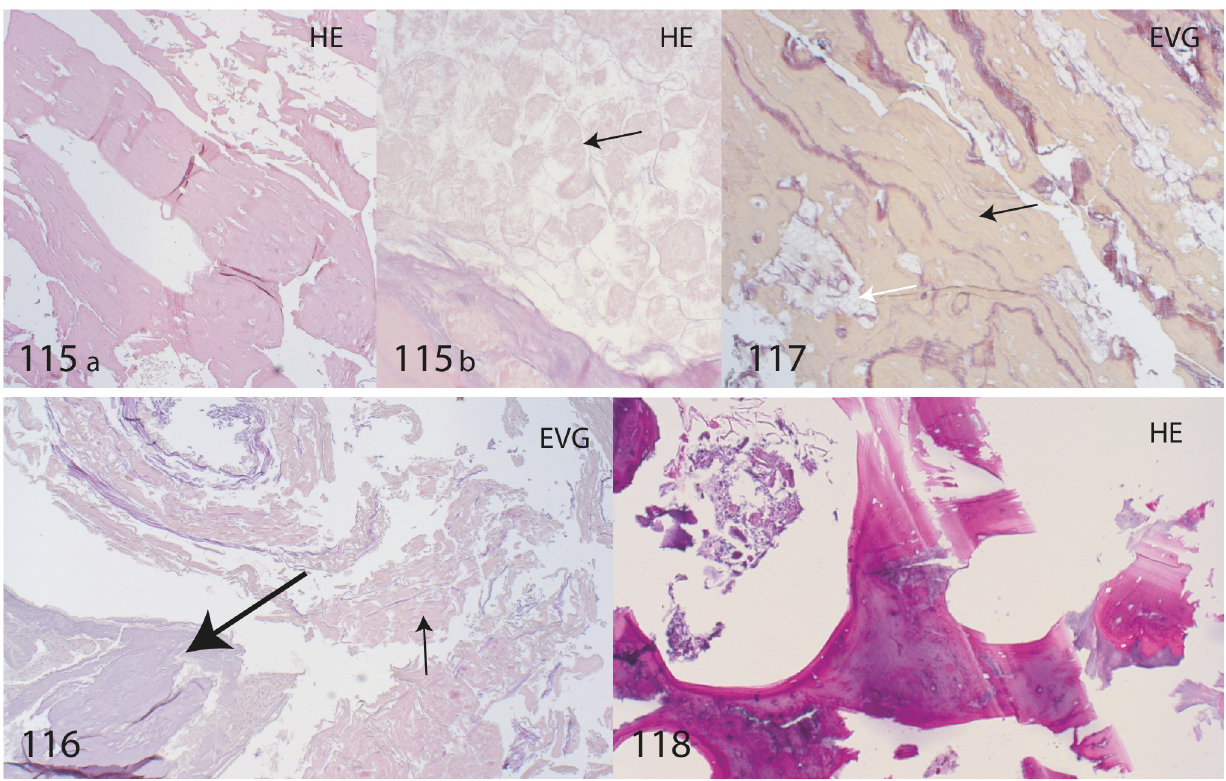
Fig 7. Histology samples of SM4. Sample number 115: arm pit with skeletal muscle (a) and fatty tissue (b) with adipocytes (arrow). 116: os pubis with cartilage tissue (big arrow) and surrounding soft tissue with connective tissue (small arrow). 117: Pectoral muscle with skeletal muscle fibres (black arrow) and fatty vacuoles (white arrow). 118: Clavicle bone with normal ‘necrotic’ spongiosa. Histological staining HE: Hematoxylin and eosin. EVG: Elastica Van